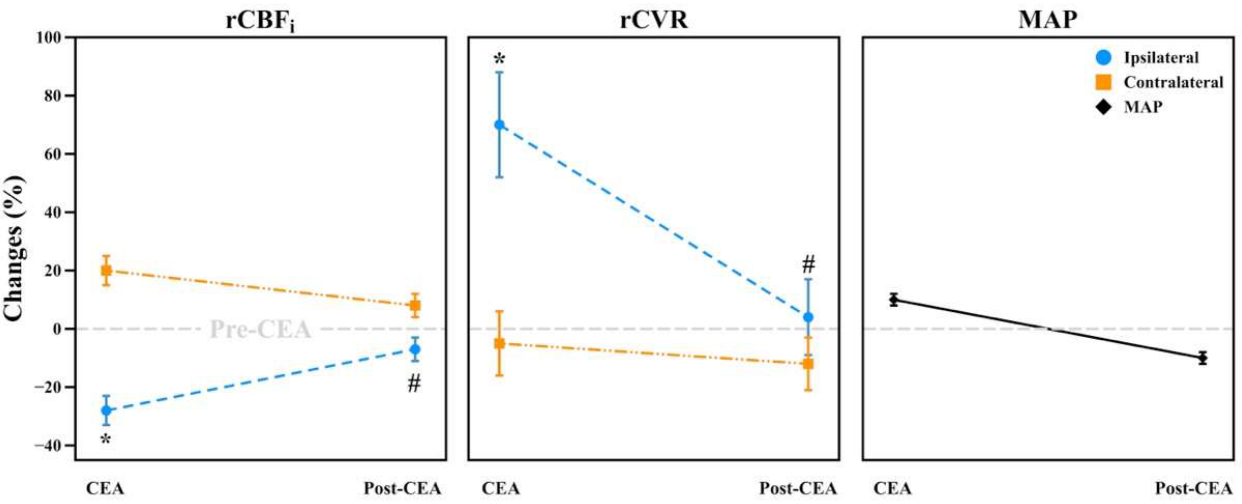
Figure 4. Hemodynamic changes in rCBF i , rCVR, and MAP of all patients during CEA and post-CEA phases. All changes were normalized with respect to the pre-CEA phase (long baseline, gray dashed line). All data are represented in mean ± standard error of the mean. Changes in the ipsilateral hemisphere were statistically significant than in the contralateral hemisphere both during CEA (indicated as *) and post-CEA phases (indicated as #). CEA, carotid endarterectomy; rCBF i , relative cerebral blood flow index; rCVR, relative cerebrovascular resistance; MAP, mean arterial pressure.